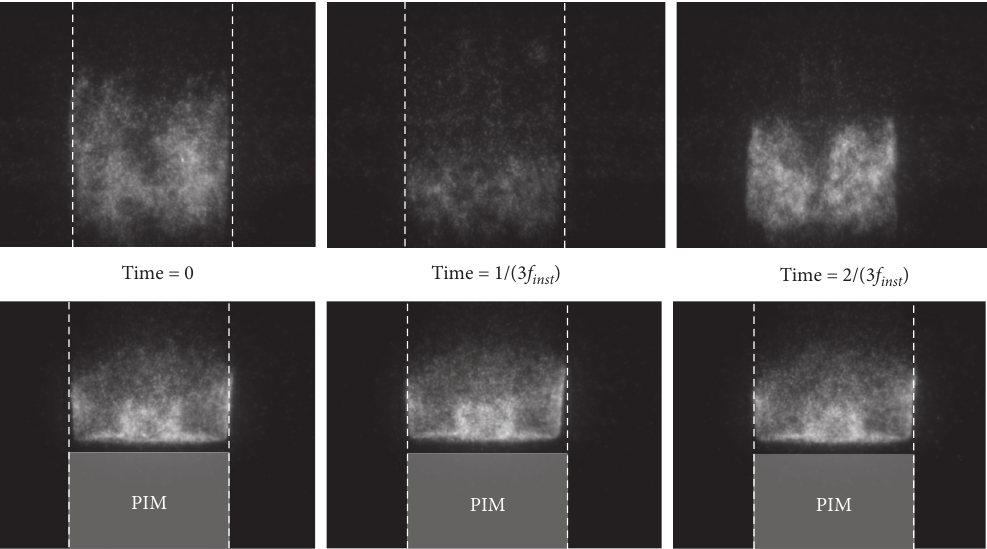
Figure 15: Raw OH ∗ images at three different time steps.